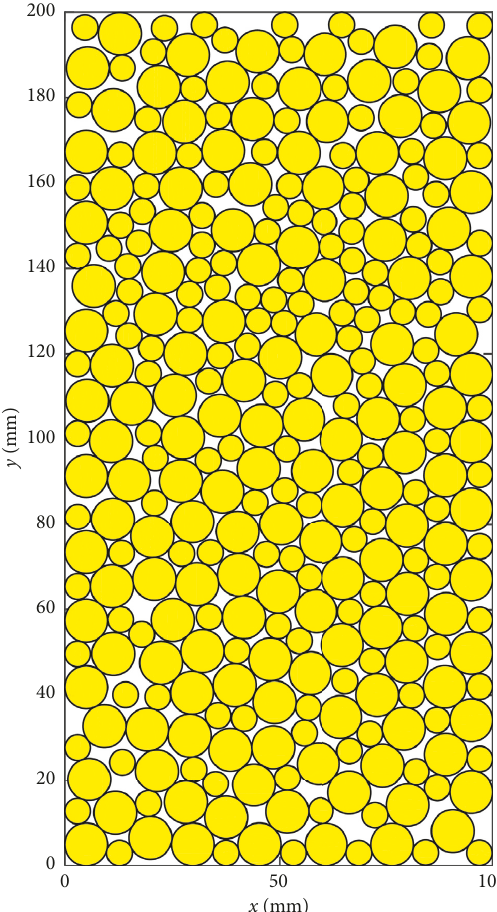
Figure 11: Particle distribution in DEM modelling.